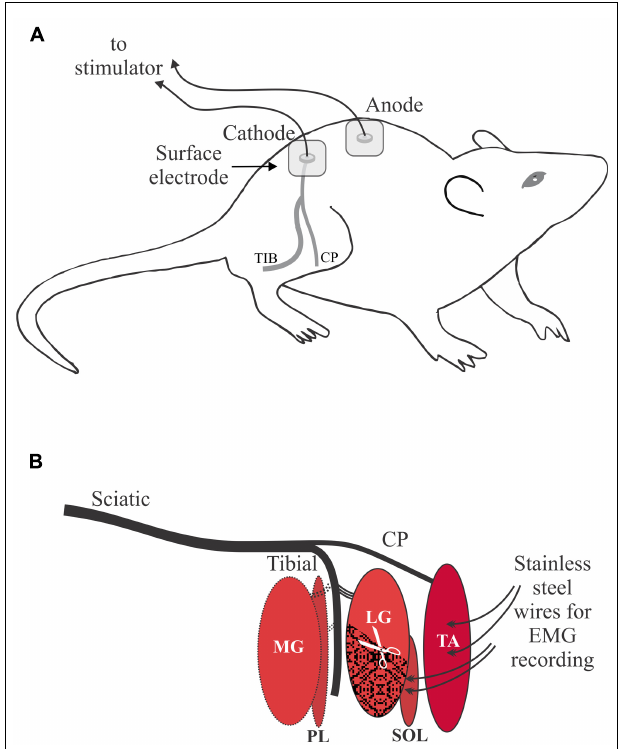
FIGURE 1 | Overview of the experimental setup. (A) Percutaneous electrical stimulation of the sciatic nerve with the cathode over the sciatic notch illustrated for the right leg. Proper skin preparation was essential under all stimulating electrodes. (B) Schematic of the branching of the sciatic nerve to the two target muscles: tibialis anterior (TA) and soleus (SOL). Other muscles of the lower leg were denervated: medial gastrocnemius (MG), plantaris (PL).The distal portion of the lateral gastrocnemius (LG) muscle was excised to reduced artifact from LG